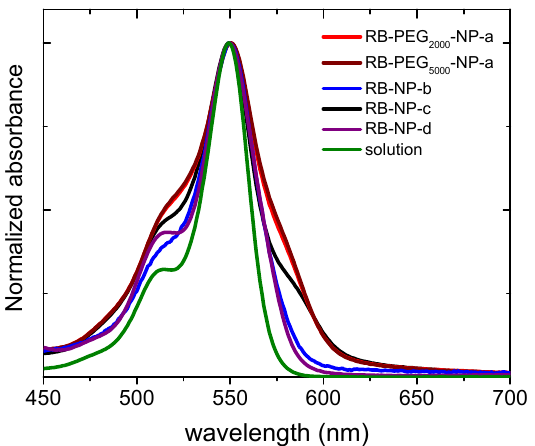
Figure 3. Normalized absorption spectra of RB-PEG 2000 -NP- a ( red ), RB-PEG 5000 -NP- a ( brown ), RB- PEG-NP- b ( blue ), RB-PEG-NP- c ( black ), RB-PEG-NP- d ( purple ) in water suspension (0.5 mg/mL) and RB in diluted aqueous solution ( green ). The absorption spectra were recorded after stirring the nanosystems for at least 24 h.